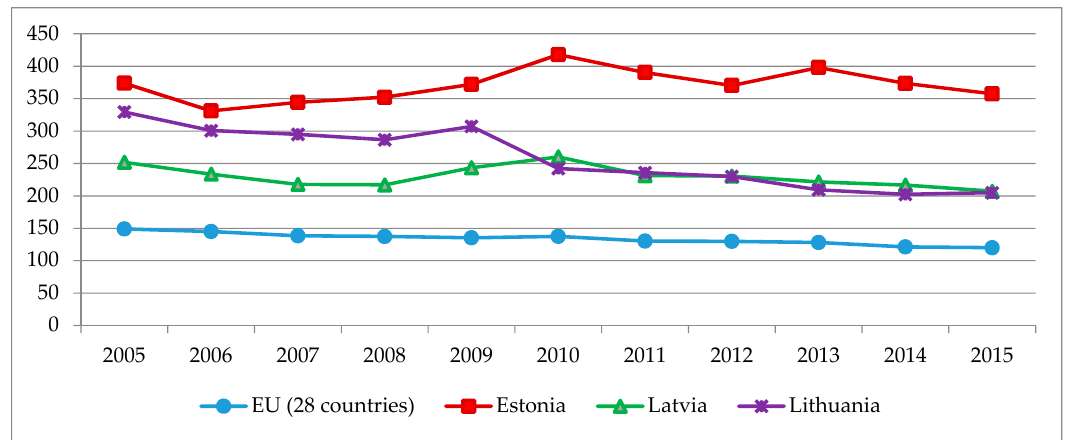
Figure 6. Energy intensity of the economy, gross inland consumption of energy divided by GDP (kg of oil equivalent per 1000 EUR).